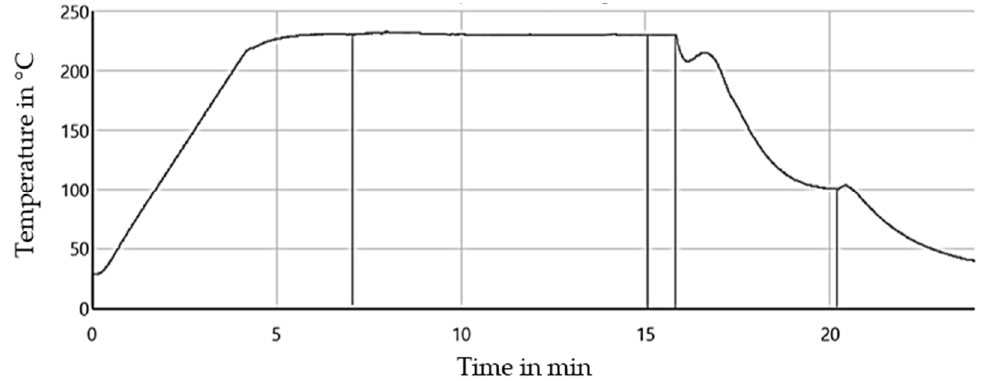
Figure 3. Temperature–time curve of the embedding process using the Fimabond.